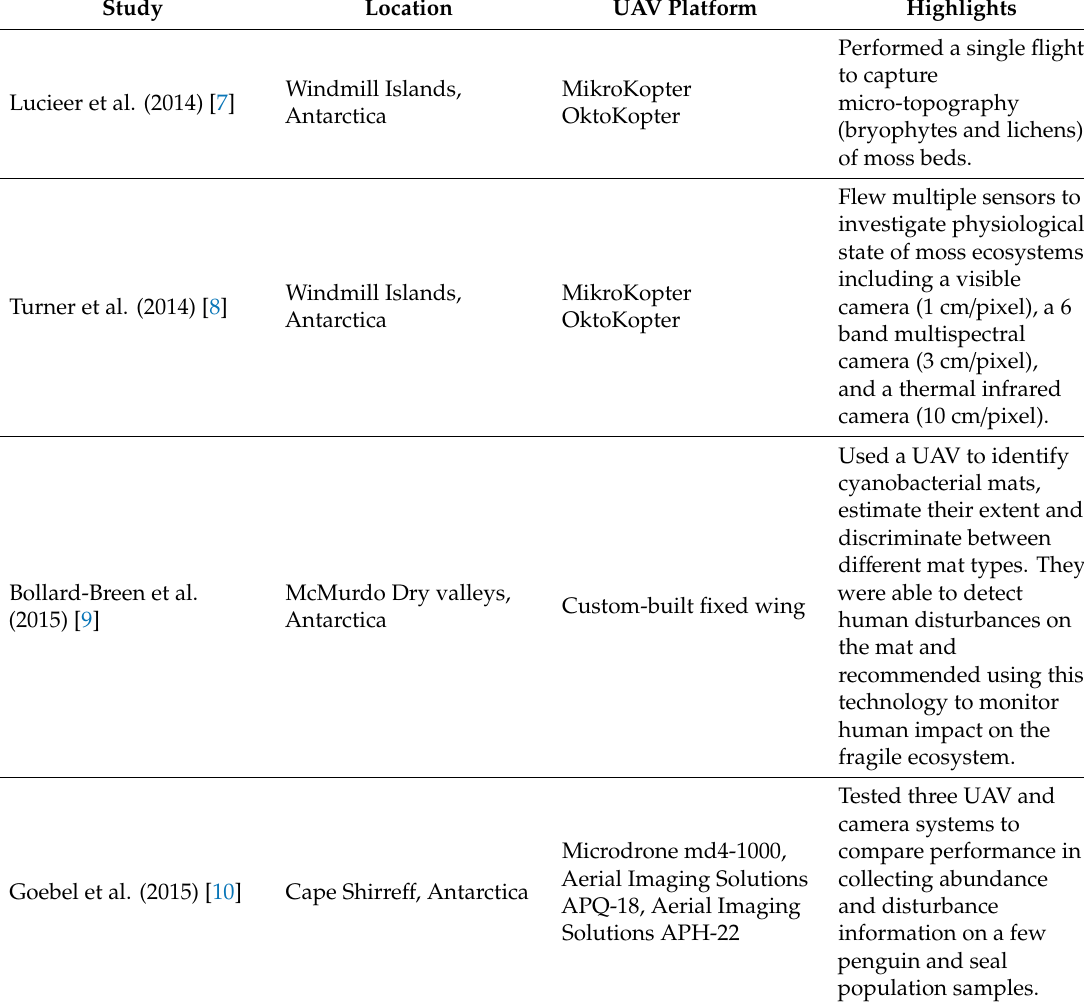
Table 1. Summary of application studies of unmanned aerial vehicles (UAVs) in cryospheric disciplines. The articles mentioned here were published online between 2014 and